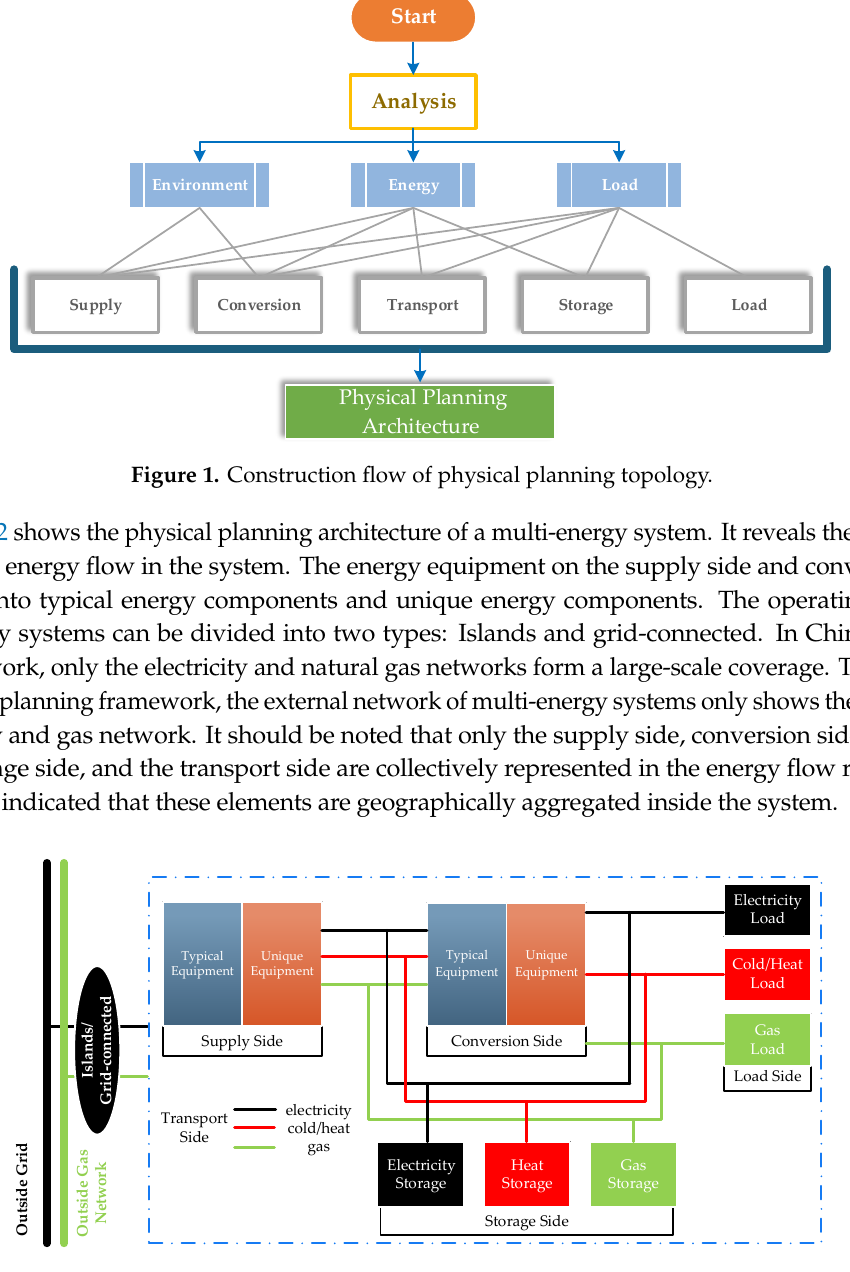
Figure 2. Physical planning topology of park-level energy regional